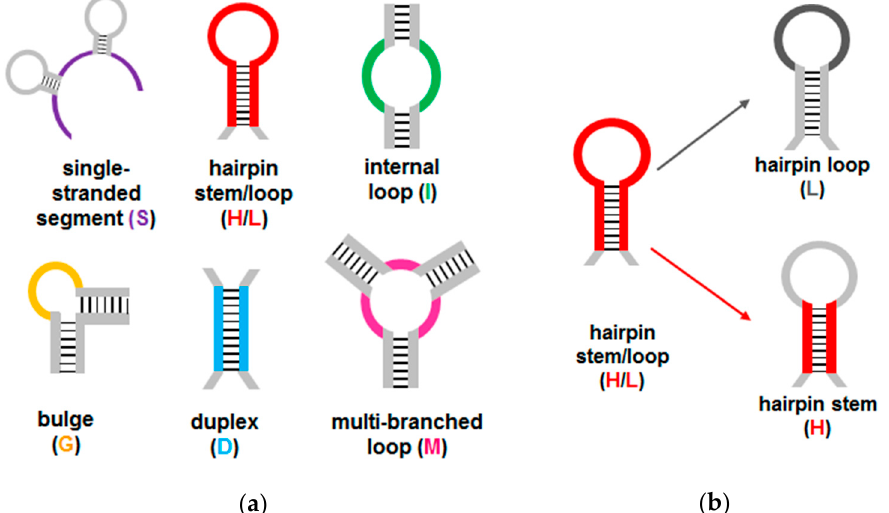
Scheme 2. Color ‐ coded illustrations and abbreviations of ( a ) six predicted secondary structure elements (SSE) namely, single ‐ stranded segment (purple), hairpin stem/loop (red), internal loop (green), bulge (yellow), duplex (blue), and multi ‐ branched loop (pink) used to identify each secondary structure family (SSF) among AuNR aptamer candidates. ( b ) Each hairpin is further broken down into a hairpin loop (gray) and hairpin stem (red) for multiple secondary structure string alignment (MSS$A) analysis.